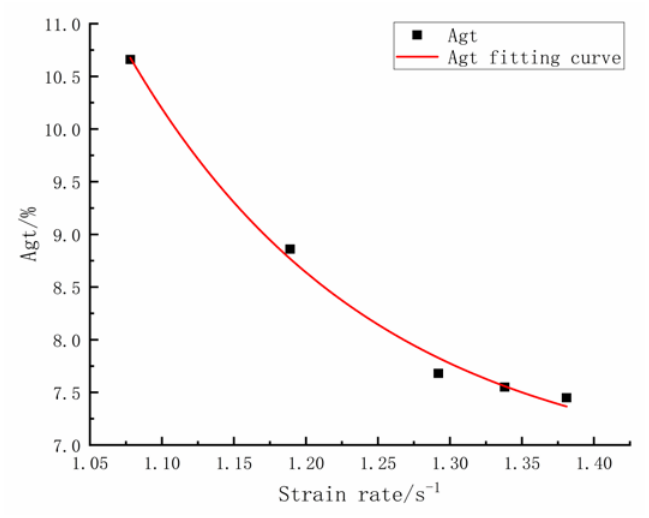
Figure 5. The change trend of strain rate — A gt .